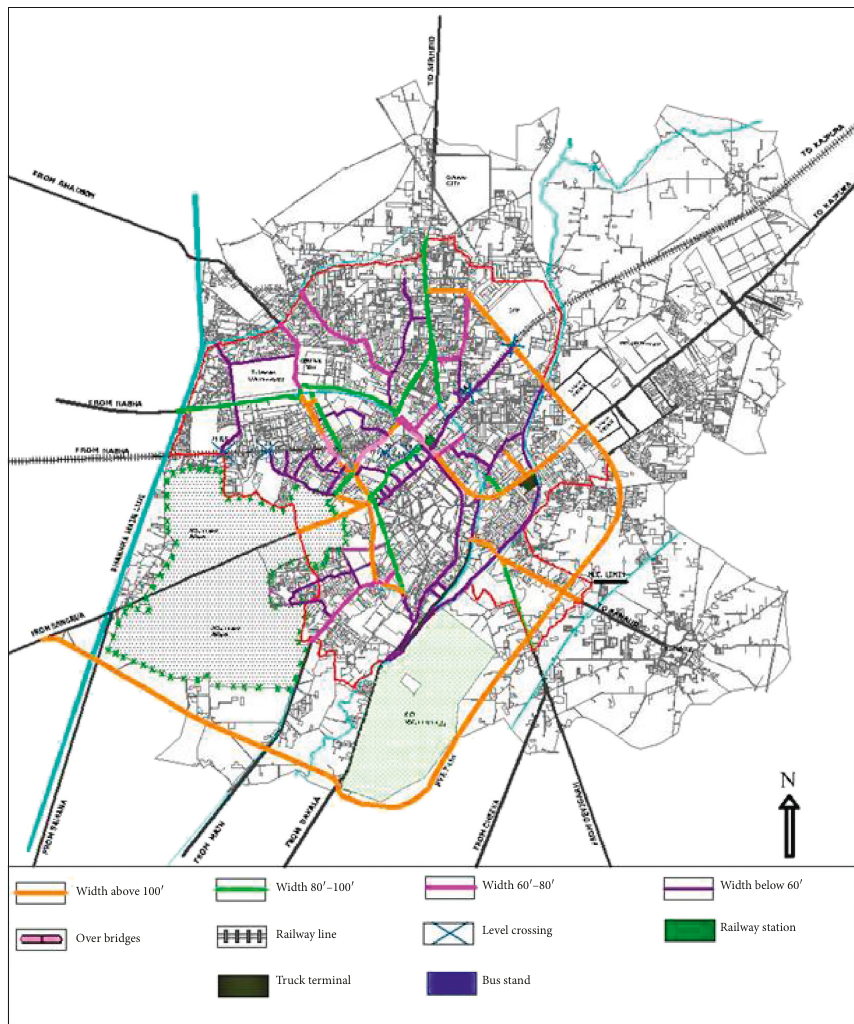
Figure 1: Map of Patiala (Punjab, India) urban road network.